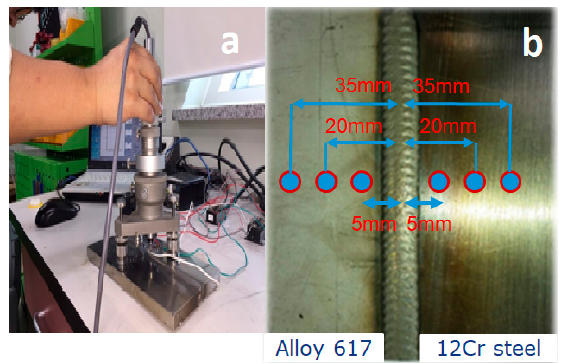
Figure 7. ( a ) RS-200 milling guide, ( b ) position of hole drilling.